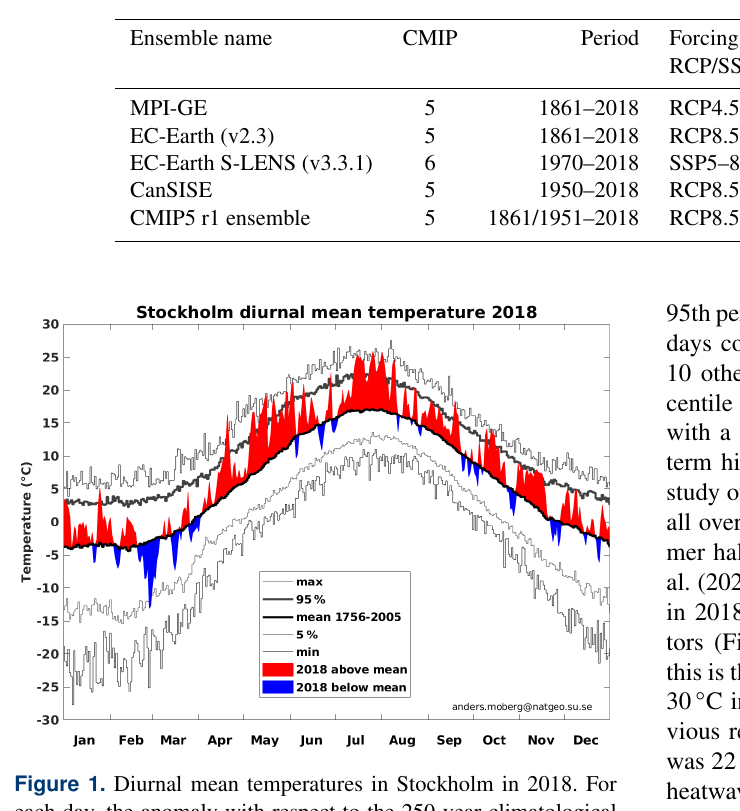
Table 2. Climate model ensembles analysed in the study.